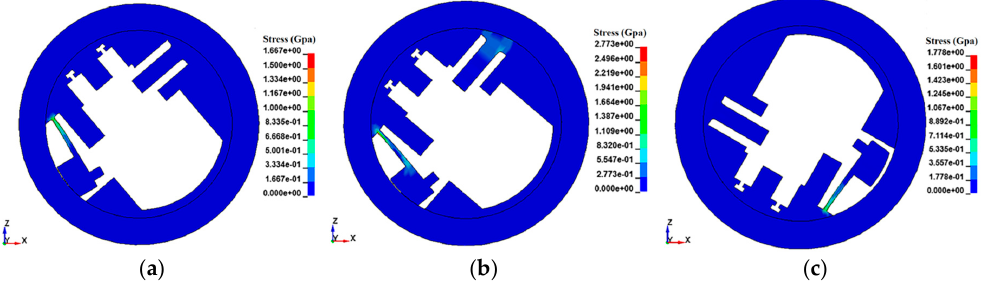
Figure 6. The simulation results of the micro S & A module under the different loads and temperatures. ( a ) Loading the centrifugal force (25 °C); ( b ) Loading the centrifugal force and setback overload (25 °C); ( c ) Loading the centrifugal force ( − 40 °C). Table 2. Simulation results under different loads and temperatures